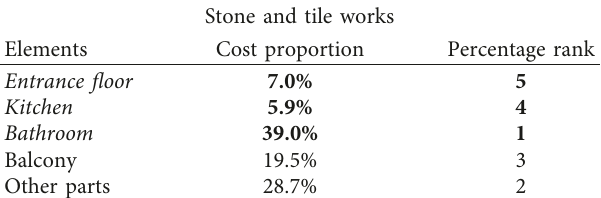
Table 2: Cost proportion analysis (stone and tile